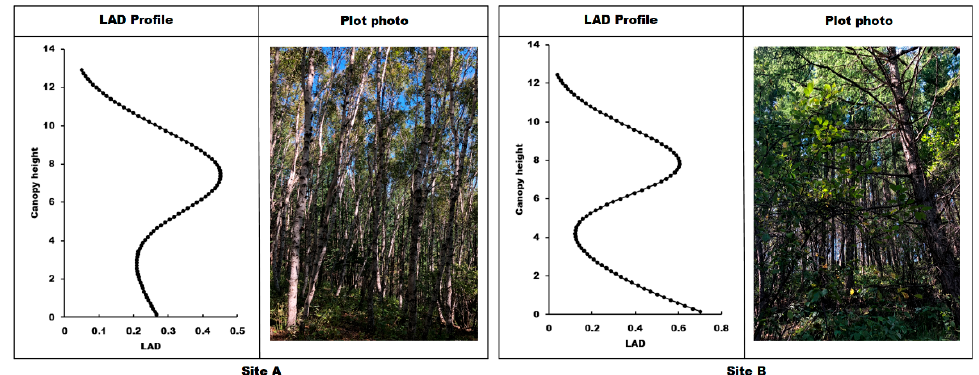
Figure 10. Examples of the LAD derived from GLAS data and the corresponding observed forest photos.